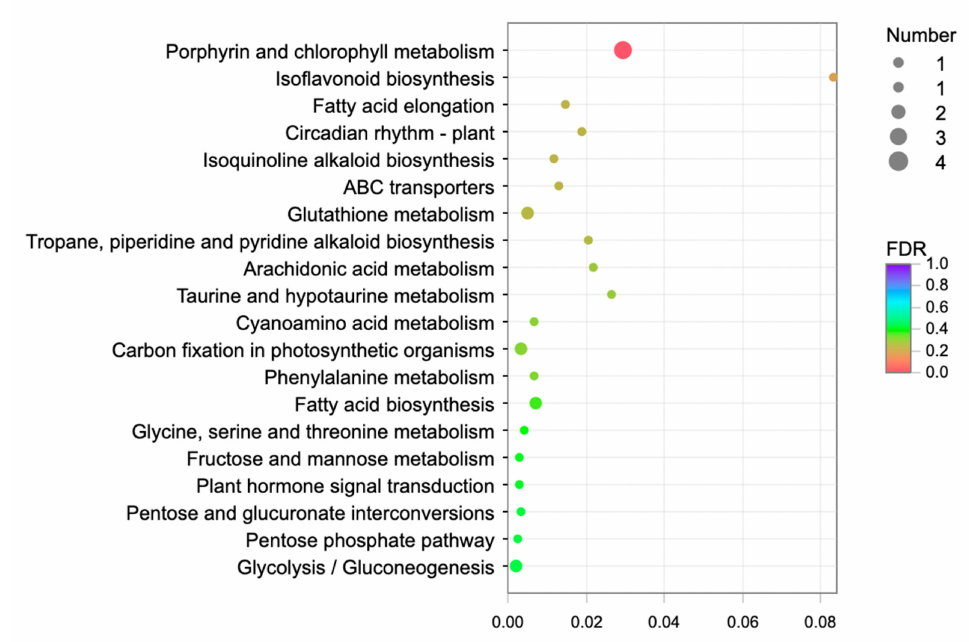
Figure 7. KEGG enrichment analysis of genes in module MEturquoise. The size of dots in the figure indicated the number of genes in this pathway, and the color of dots corresponded to different Qvalue ranges.